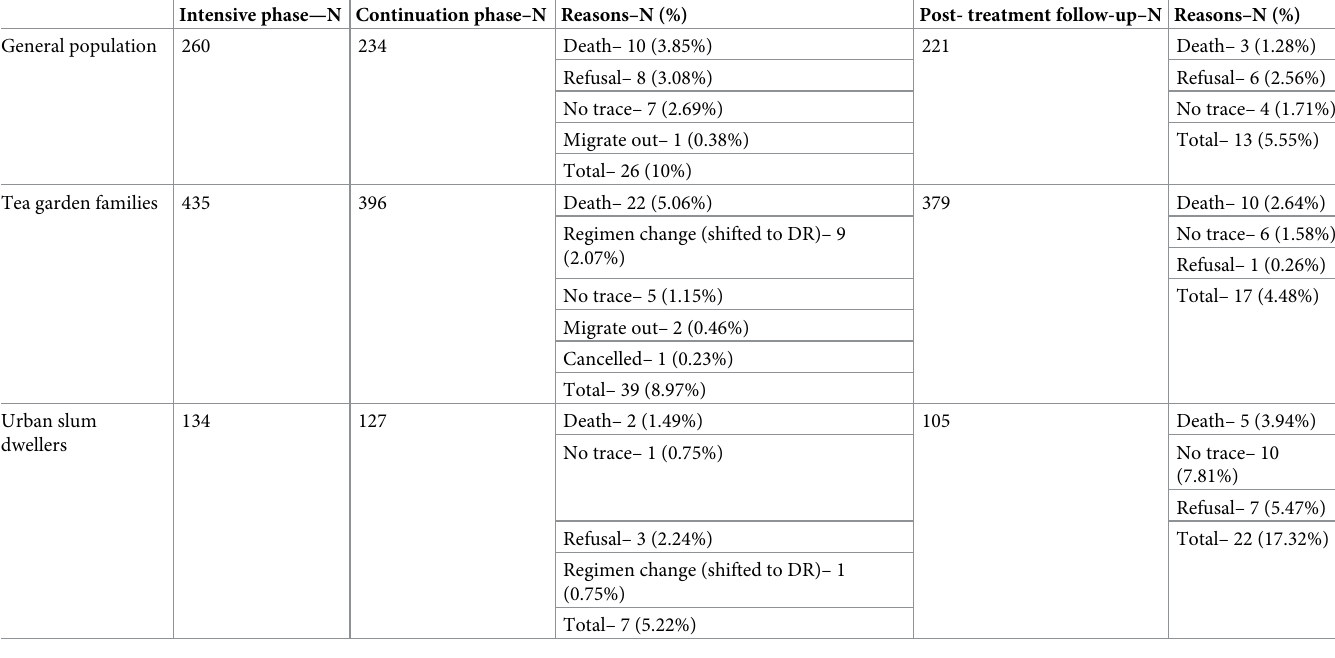
Table 1. Reasons of loss to follow